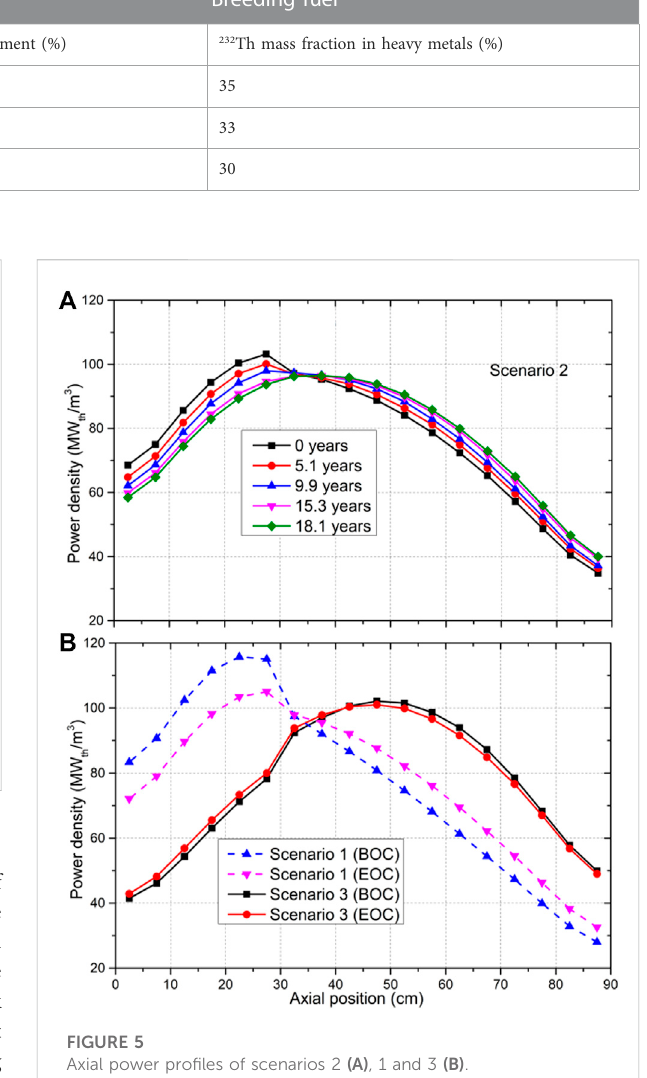
FIGURE 5 Axial power pro fi les of scenarios 2 (A) , 1 and 3 (B)